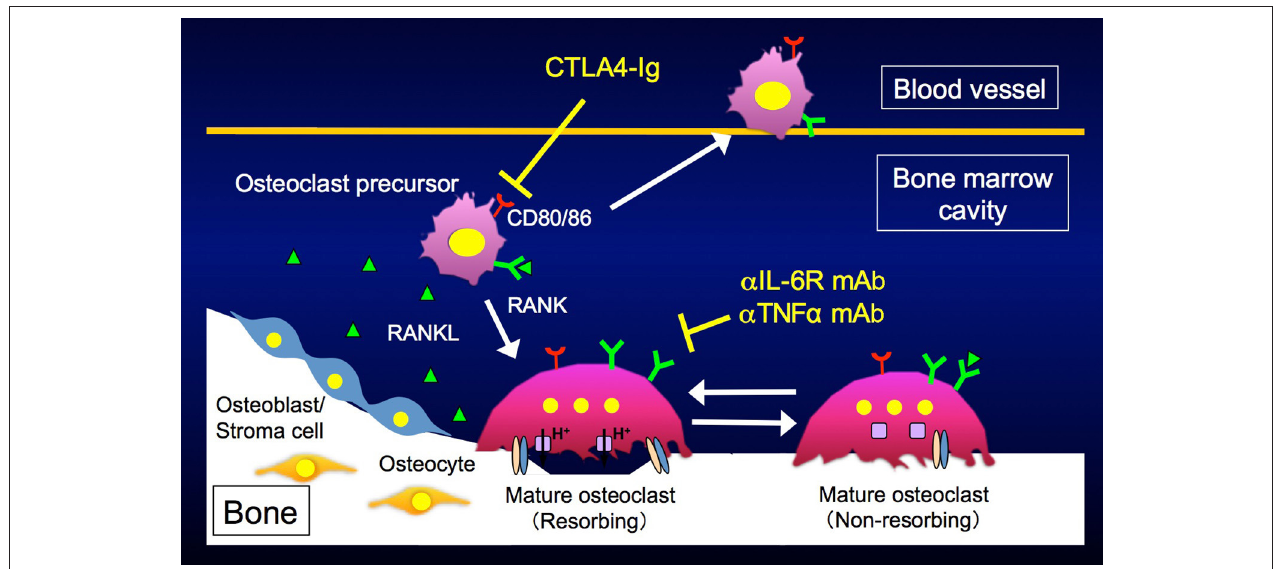
FIGURE 3 | Different modes of action of biological disease-modifying antirheumatic drugs (DMARDs). Anti-IL6R and anti-TNF α monoclonal antibodies affect mature osteoclasts and switch bone-resorbing osteoclasts to non-resorbing cells. CTLA4 mobilizes osteoclast precursors, eliminating their attachment to bone surfaces.